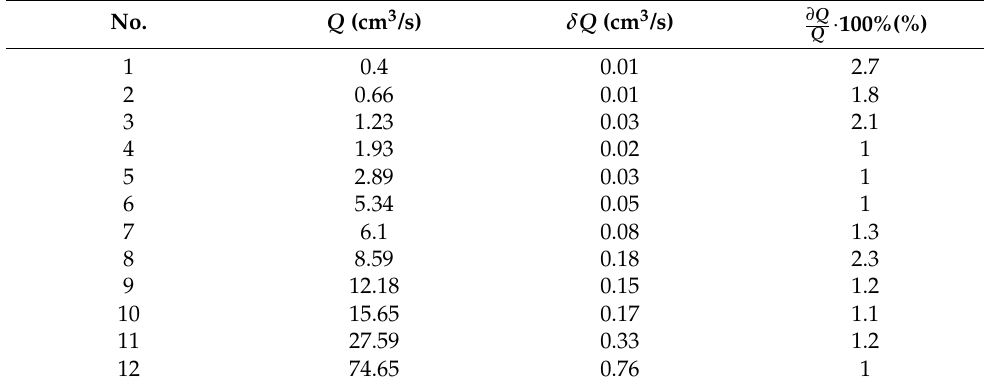
Table 1. Summary of volumetric flow measurement results with